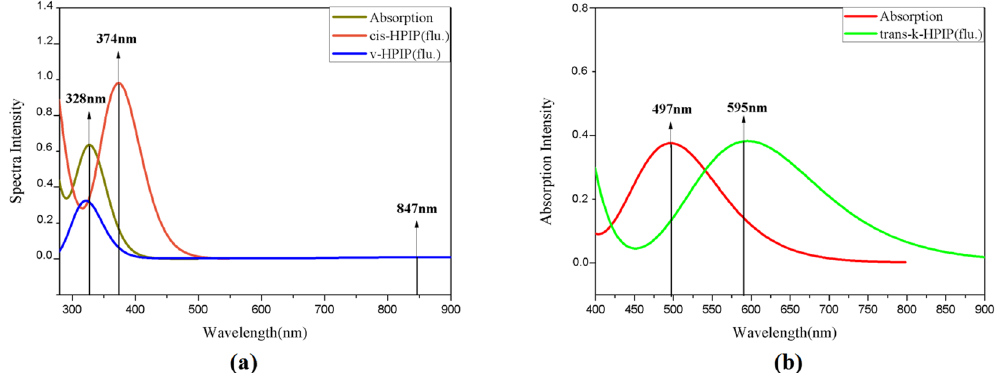
Figure 5. Theoretically simulating the absorption and fluorescence spectra of the HPIP in the mixed liquid model. ( a ) The electron spectra for the cis-HPIP and v-HPIP, ( b ) the electron spectra for the trans-k-HPIP. The detail explanations of curves can be given by the legend on the top right corner.